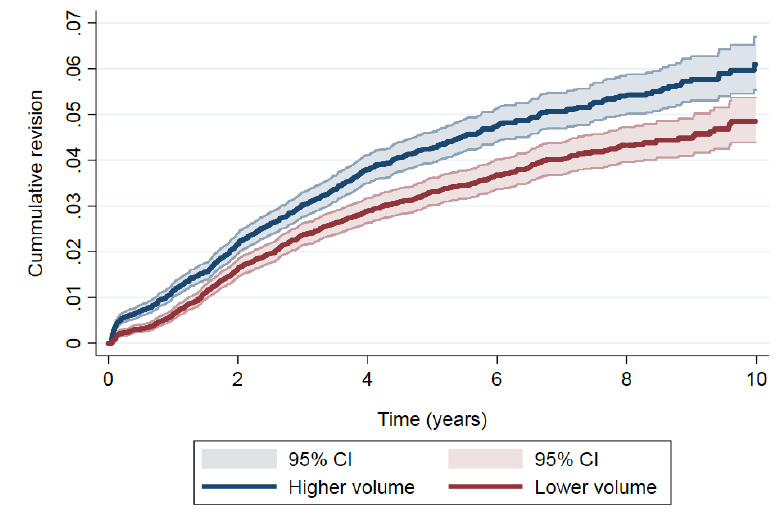
Figure 4. Cumulative revision in total knee arthroplasty (TKA).